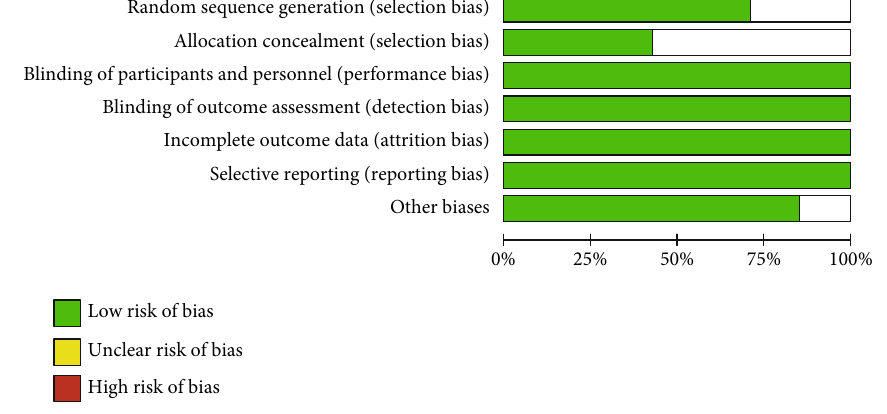
Figure 2: Characteristics of included studies.